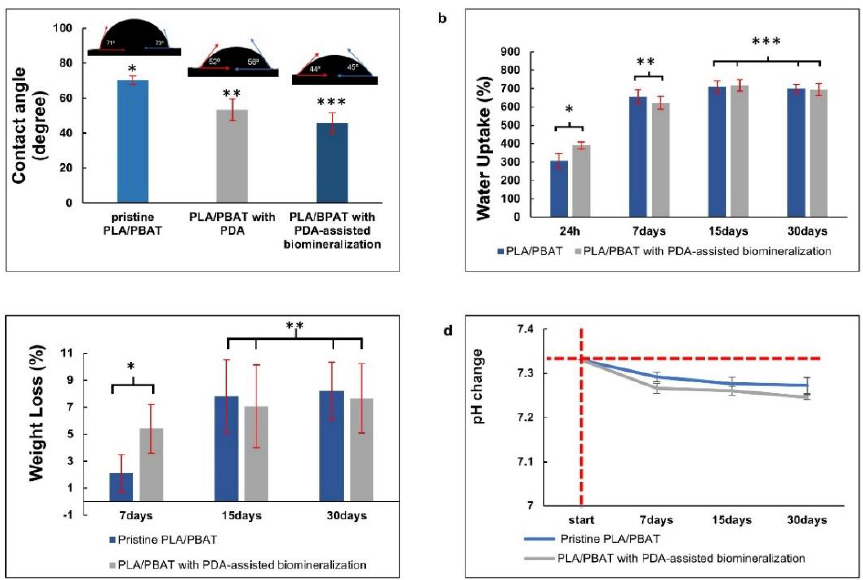
Figure 8. The in vitro degradation tests. The average water contact angles ( a ), the water uptake (%) ( b ), and the material weight loss (%) versus degradation time ( c ) of the PLA/PBAT scaffold with and without surface modification, and the pH alteration of the degradation medium ( d ). The vertical and horizontal red dashed lines represent the starting point of the investigating period and the initial pH of the soaking medium, respectively. The different numbers of asterisks indicate statistical significance ( p ≤ 0.05).